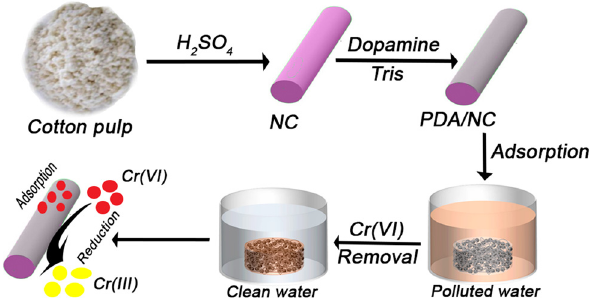
Scheme 1: Schematic illustration of the PDA/NC nanocomposite synthesis for the removal of Cr ( VI )